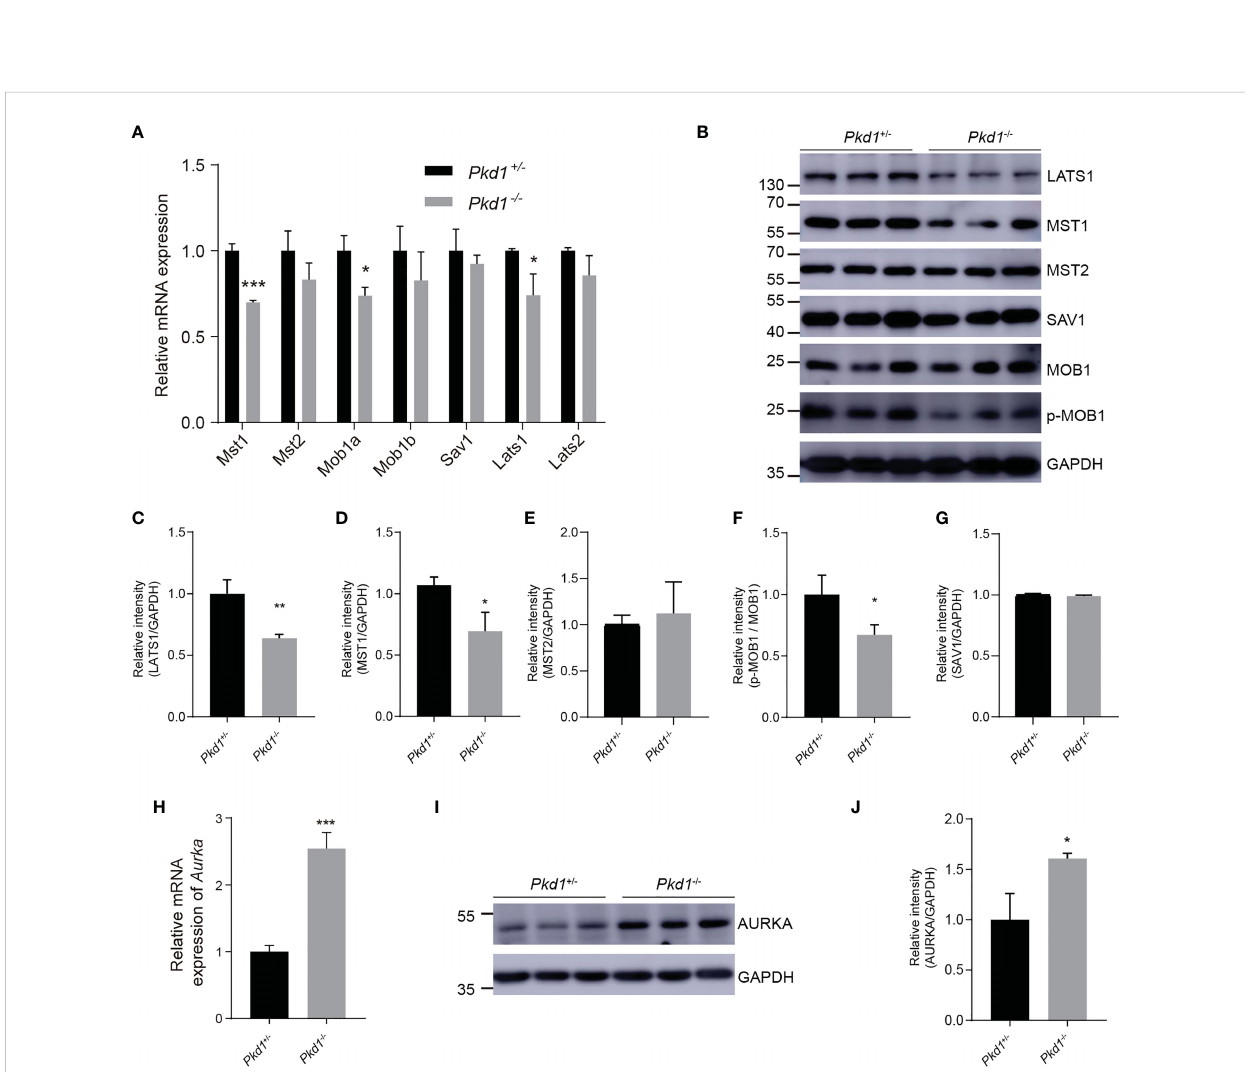
FIGURE 4 The restrained Hippo signaling pathway and increased AURKA. (A) Relative mRNA expression of core components of the Hippo kinase cascade. (B) Representative western blotting images of core components of the Hippo signaling pathway with GAPDH as the loading control. (C – G) Relative intensities of LATS1, MST1, MST2, p-MOB1, and SAV1, respectively. (H) Relative mRNA expression of Aurka in Pkd1 +/- and Pkd1 -/- cells. (I) Representative western blotting images of AURKA. (J) Relative intensity of AURKA. All error bars indicate standard deviation of three